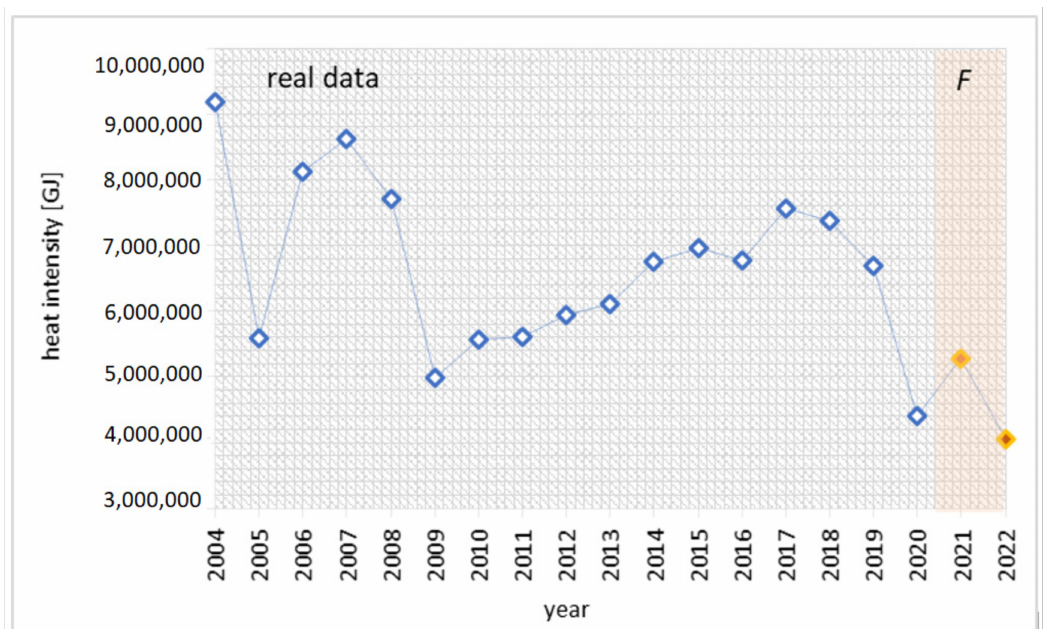
Figure 8. Heat intensity in Polish steel industry in the period 2004–2022. Source: own elaboration.